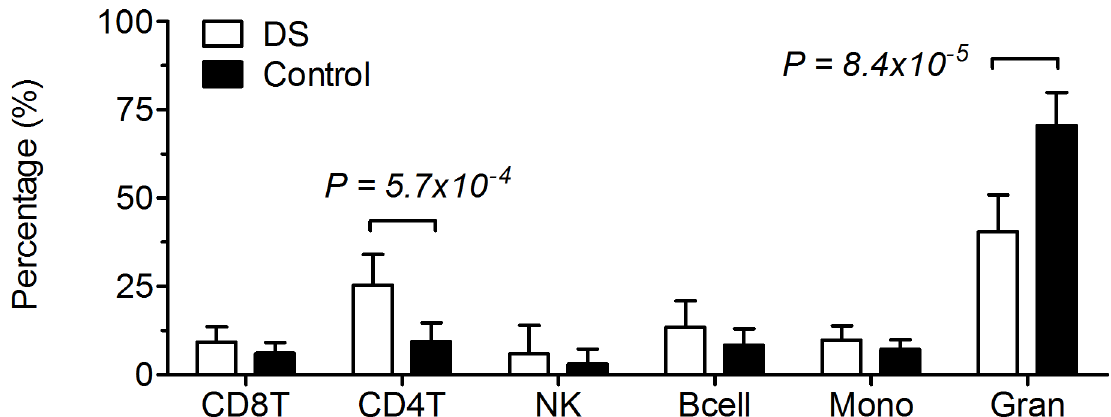
Fig 1. Estimated blood cell distribution. Relative estimated distribution of CD8+ and CD4+ T cells, natural killer cells, B cells, monocytes, and granulocytes among down syndrome (DS) and controls.